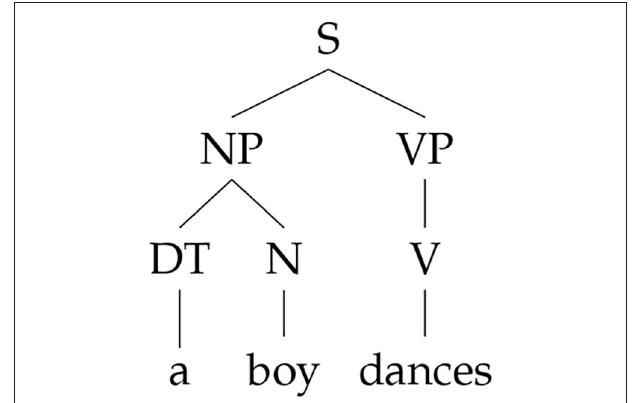
FIGURE 1 | Phrase structure of a boy dances